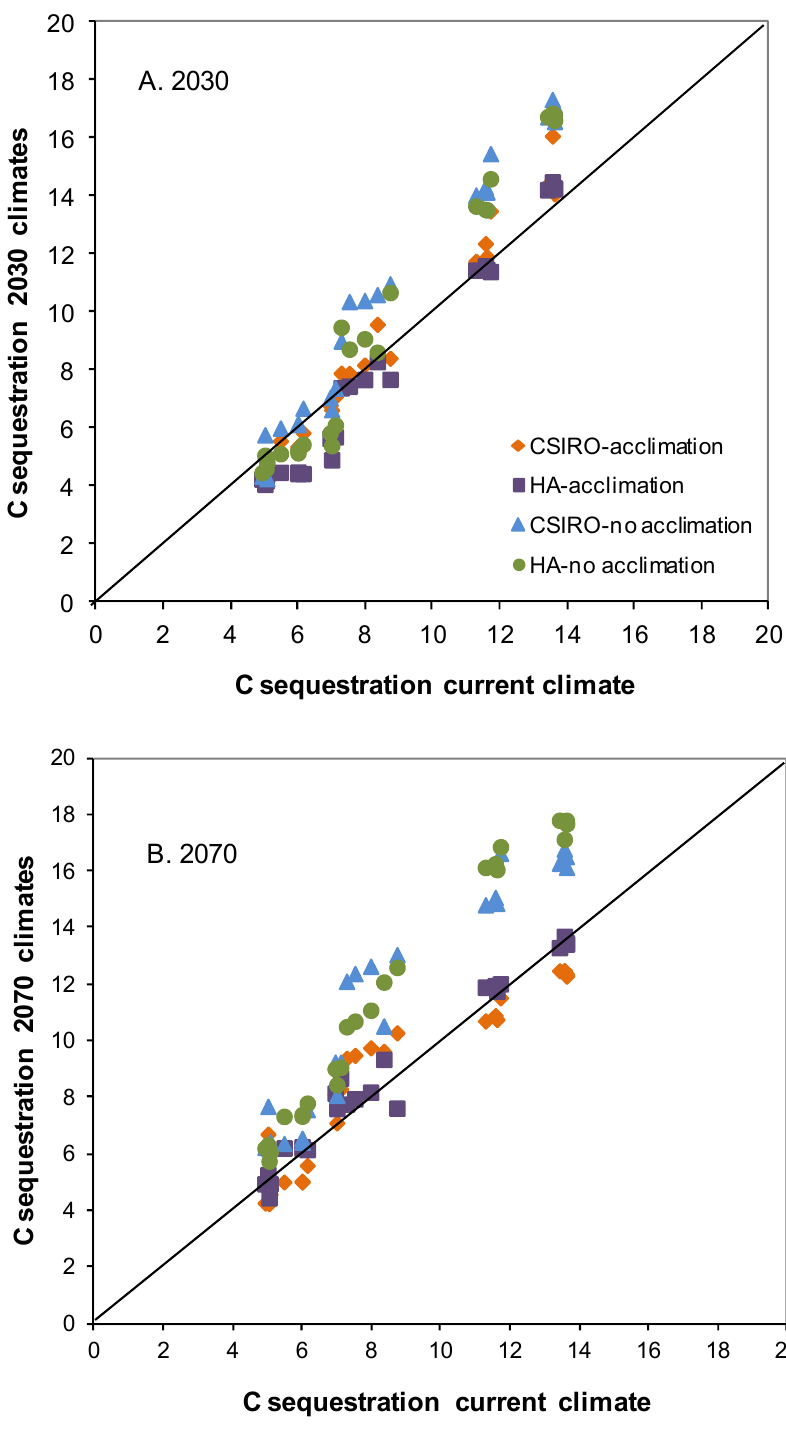
Figure 2. Relationship between estimates of C sequestration under current climate and ( A ) 2030 and ( B ) 2070 climate scenarios for E. globulus stands in southern Australia, for two climate models and assuming either no or full photosynthetic acclimation to elevated CO . Values are mg·ha − 1 ·year − 1 2